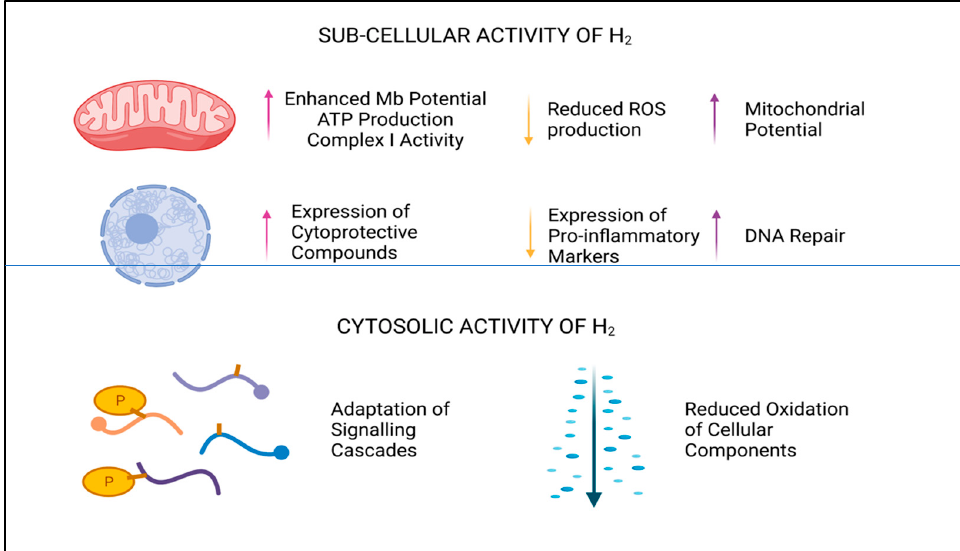
Figure 2. Subcellular and cytosolic activity of H 2 . Legend: Graphical overview of the cellular and subcellular influence H 2 has within cells.